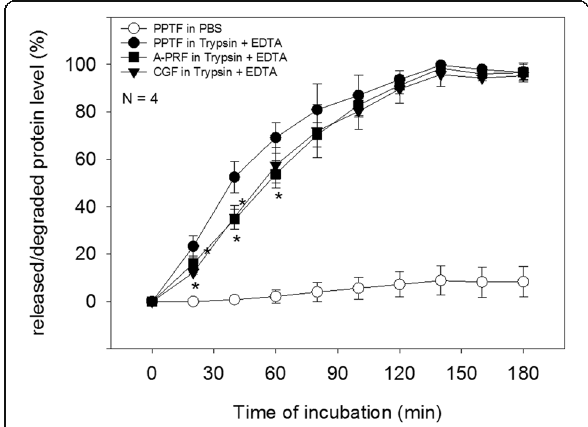
Fig. 3 Enzymatic degradability of A-PRF, CGF, and PPTF membranes. Each membrane disk ( φ 8 mm, 1 mm thick) was immersed in PBS containing trypsin and incubated in a CO 2 incubator. N = 4. The asterisks represent significant differences ( P < 0.05) compared with A-PRF at the same time points Fig. 3, PPTF membranes degraded significantly faster than A-PRF and CGF membranes. This disparity in de- gradability was observed at 20 and 40 min.